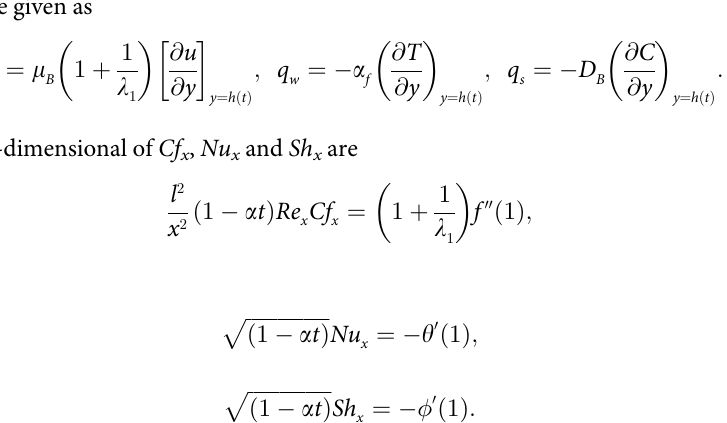
¼ (cid:0) y 0 ð 1 Þ ; Nu x ¼ (cid:0) � 0 ð 1 Þ : Sh x